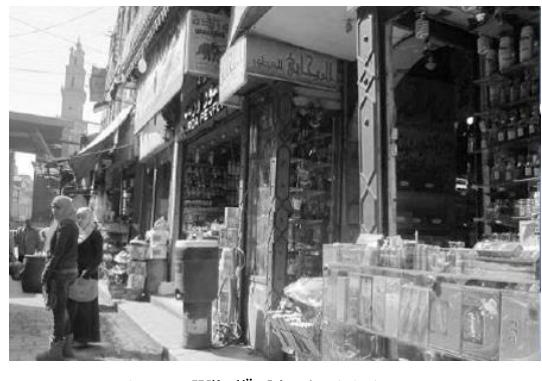
Figure 6. Wikāliẗ ạl-’Anbariyin in 2015.